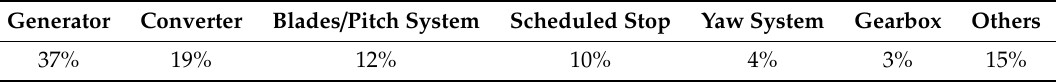
Table 1. Percentage of downtime per wind turbine subsystem